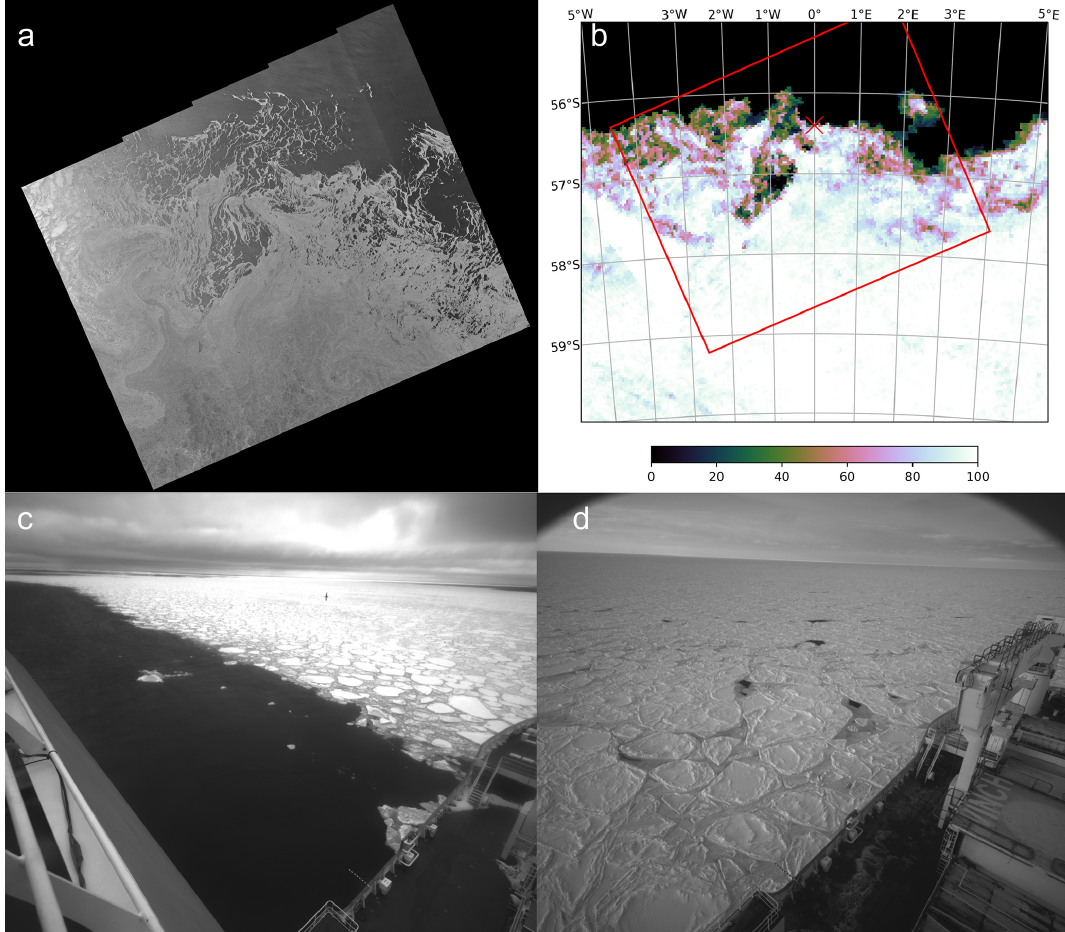
Figure 1. Example of sea ice conditions in the marginal ice zone at the edge with the ocean in austral spring and about 200km into the pack ice in austral winter. (a) SAR image from the European Space Agency Sentinel-1B (Ground Range Detected, acquired on 21 October 2019 at 19:21:53GMT, obtained from http://www.seaice.dk (last access: 15 May 2022) at 300m resolution, with credits to Roberto Saldo, DTU Space and the Technical University of Denmark). (b) Sea ice concentration from AMSR2 on the same day in stereographic polar projection (3.125km resolution, processed by the University of Hamburg and obtained from ftp://ftp-projects.cen.uni-hamburg.de/seaice/AMSR2/3. 125km, last access: 15 May 2022) showing the footprint of the SAR image and the location of the icebreaker SA Agulhas II on the morning of 22 October 2019. (c) Sea ice conditions before entering the MIZ at the location shown by the red cross in panel (b) . The sharp transition is the wake of the ship after reaching the sampling position. (d) Cemented pancake ice floes in austral winter (observed from the SA Agulhas II on 27 July 2019 at 57 ◦ S, 0 ◦